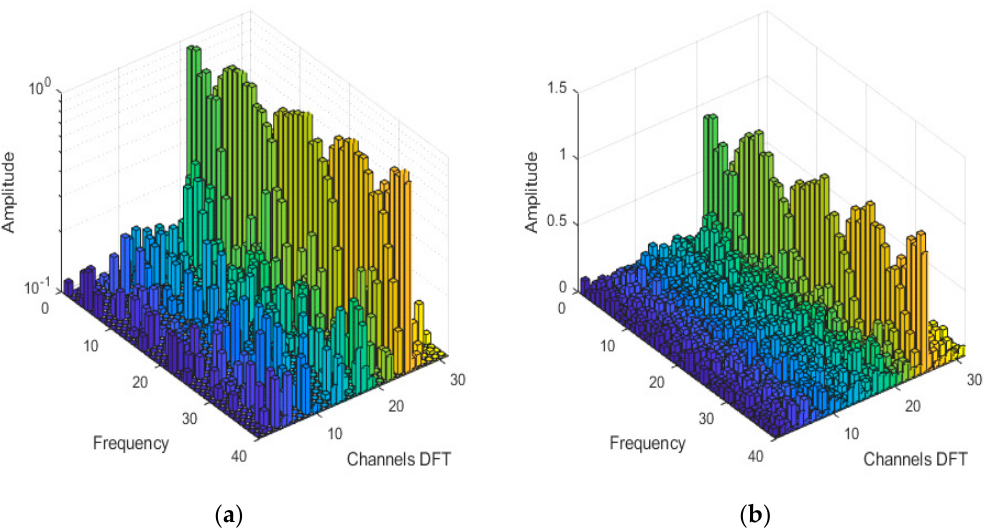
Figure 8. The magnitude response of the DFT channels: ( a ) Logarithmic scale; ( b ) linear scale.